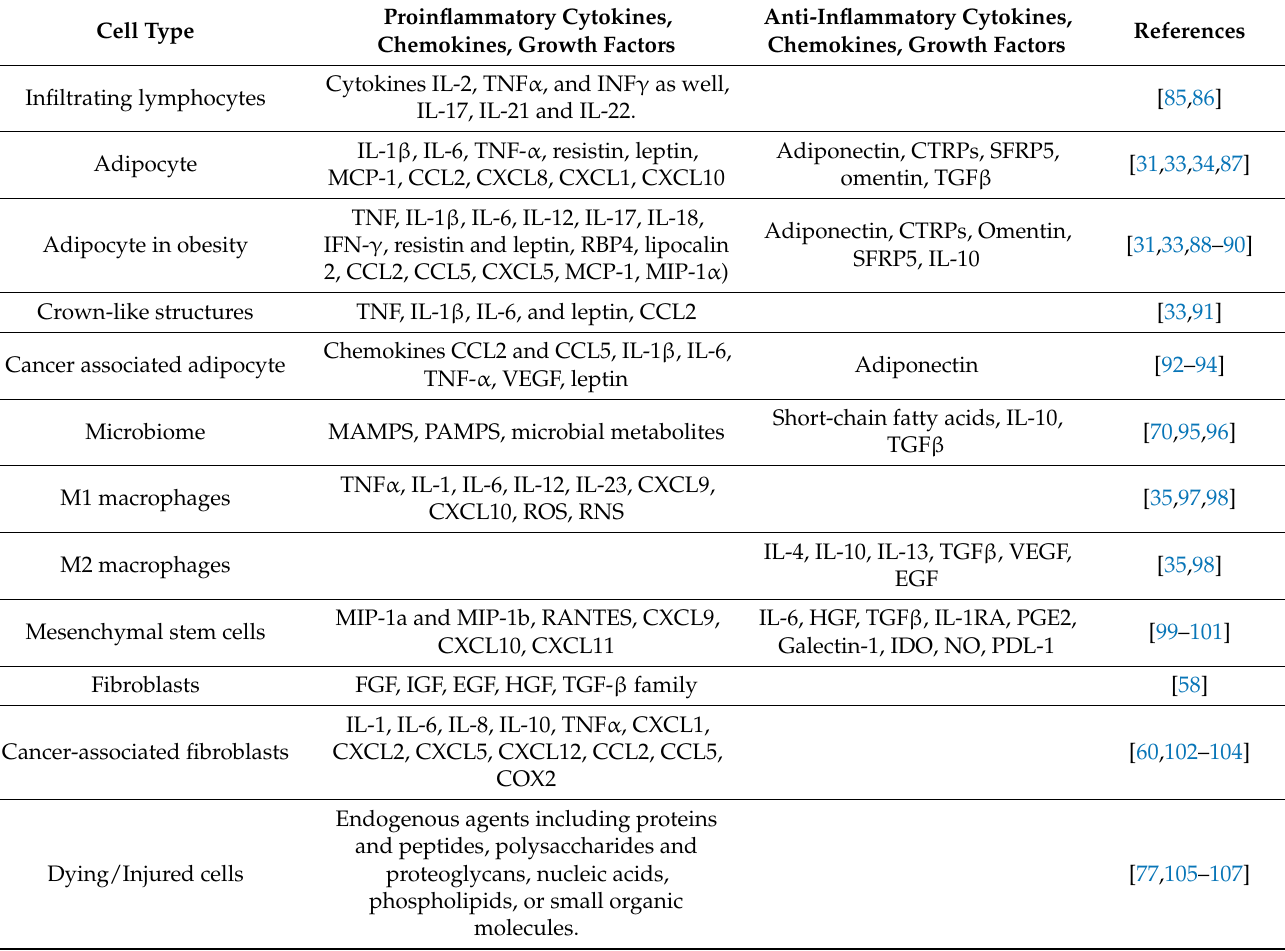
Table 2. Cellular proinflammatory and anti-inflammatory